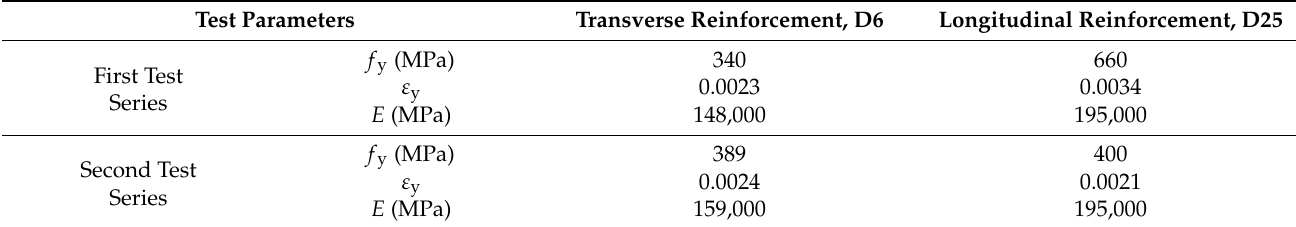
Table 2. Material properties.